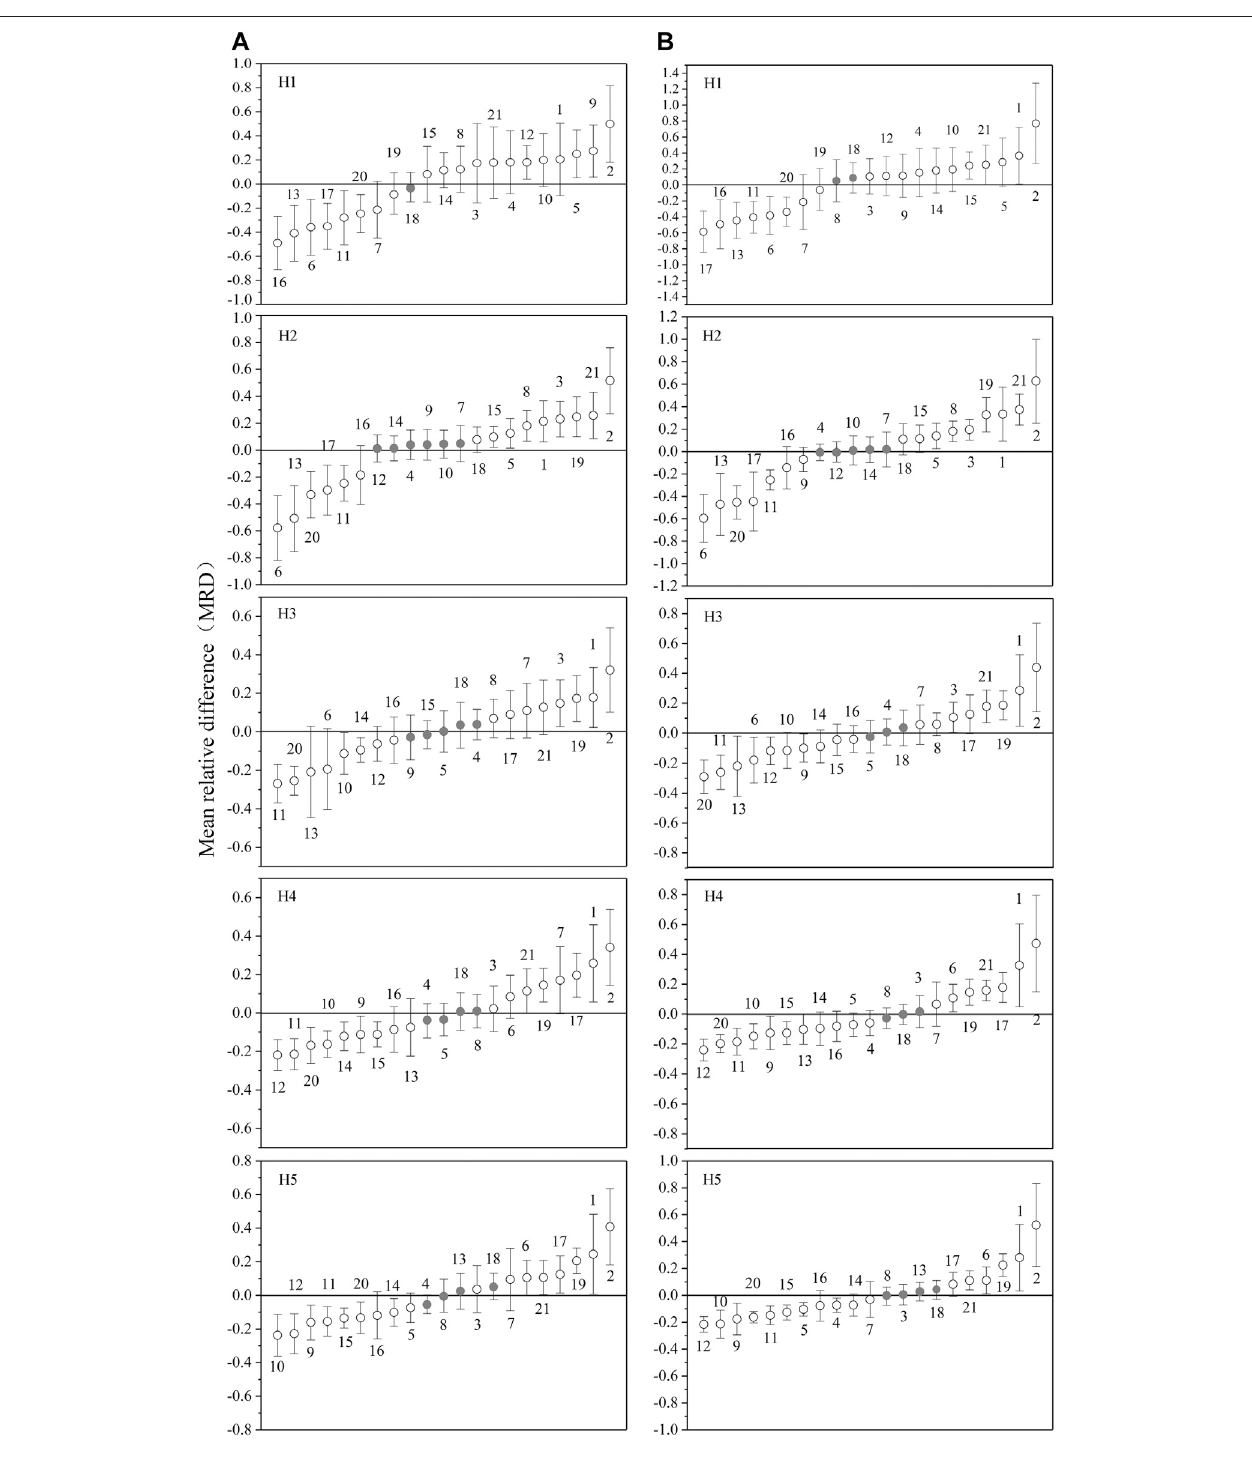
FIGURE 6 | The mean relative differencesof each different soil depth in the rainy season (A) and dry season (B) . The error bar represents the standard deviation of the relative difference. The gray solid circle is the representative location of each soil layer.